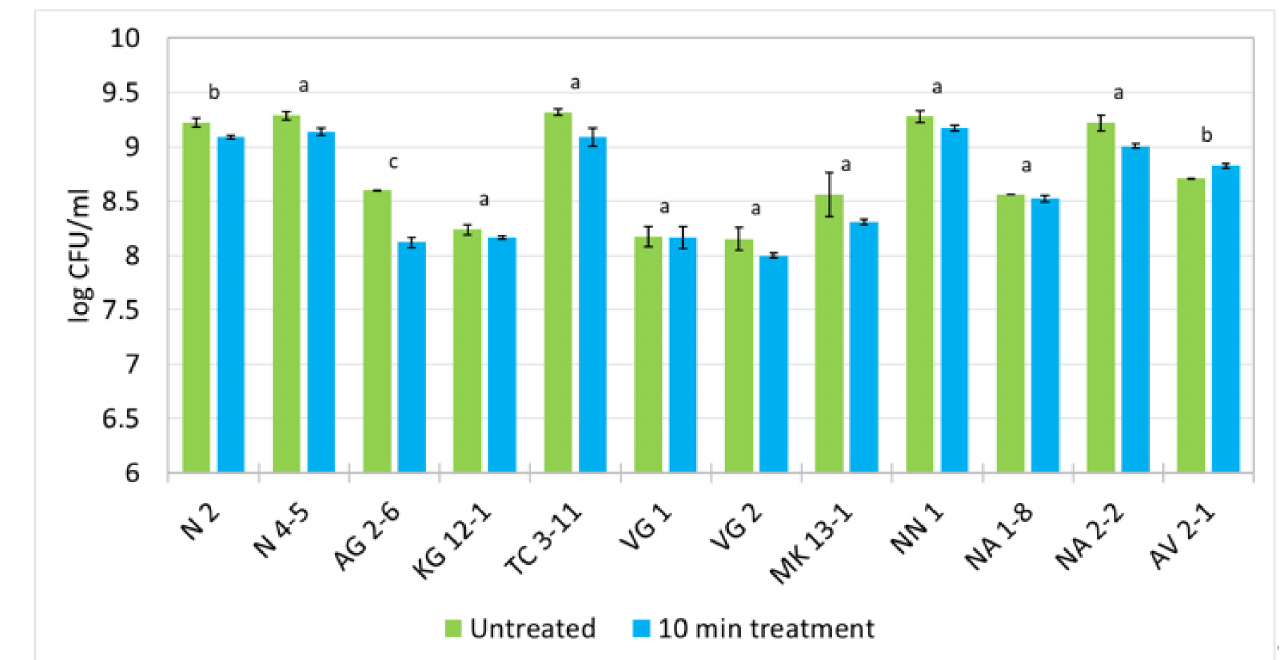
Figure 1. Survival ability of the newly isolated lactic acid bacterial strains under simulated oral stress conditions. Means: a —nonsignificant ( p > 0.05); b and c —significant ( p < 0.05 and p < 0.01,